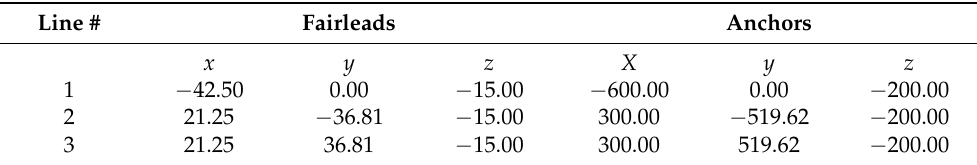
Table 3. Mooring line coordinates (unit: m).